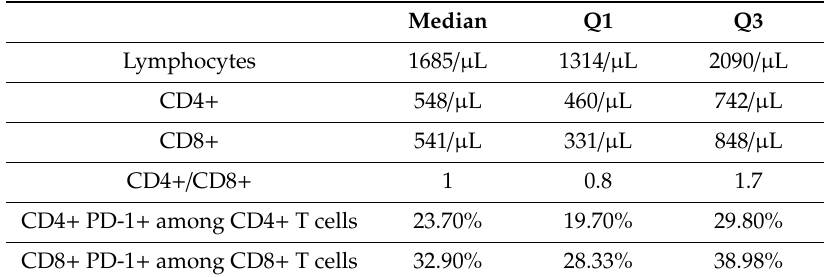
Table 2. Median values, 1st and 3rd quartiles for total lymphocyte count, T CD4 + , T CD8 + , T CD4 +